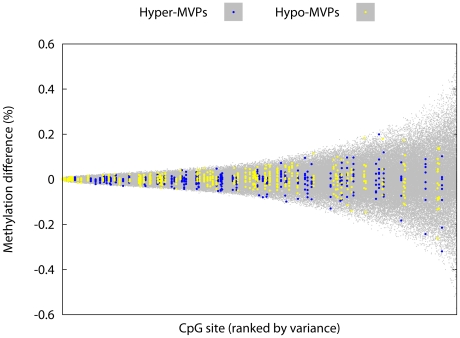
T1D–MVPs are not due to increased technical and/or biological variability.We generated Illumina27K profiles for CD14+ cells from 9 different control MZ pairs and calculated intra-MZ pair methylation differences at each probe on the Illumina27K array, for each of the 9 different MZ pairs. Here we plot the variance (around the mean) observed in intra-MZ pair methylation differences at each probe over all 9 MZ pairs (i.e. each ‘column’ of data contains 9 different data-points). For each MZ pair, the choice of the ‘index’ co-twin was arbitrary. CpG sites were ranked in order of increasing sample variance across the 9 intra-pair differences measured at each site. The range of intra-MZ pair variability at T1D–MVP-corresponding probes (highlighted) is significantly less compared with the range of variability observed across other probes on the array (P = 2.4×10−8, Welch's t-test). Number of probes used in this analysis = 22,645 (of the total 27,458 probes on the array. Refer to the section ‘Array Processing’ in Materials and Methods for the Q.C. steps performed on the arrays).